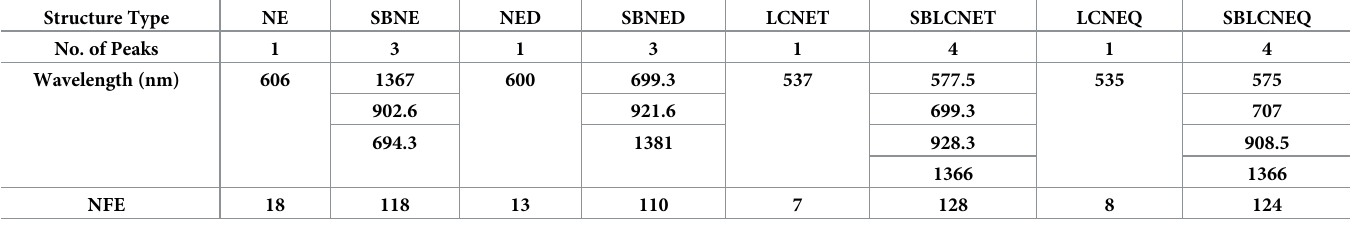
Table 2. Characteristic parameters of the elliptical nano-structures for the y-polarization with outer semi-axis a = 90 nm and inner semi-axis b = 60 nm, thickness t = 40 nm for NE, NED, LCNET, and LCNEQ. Structure Type